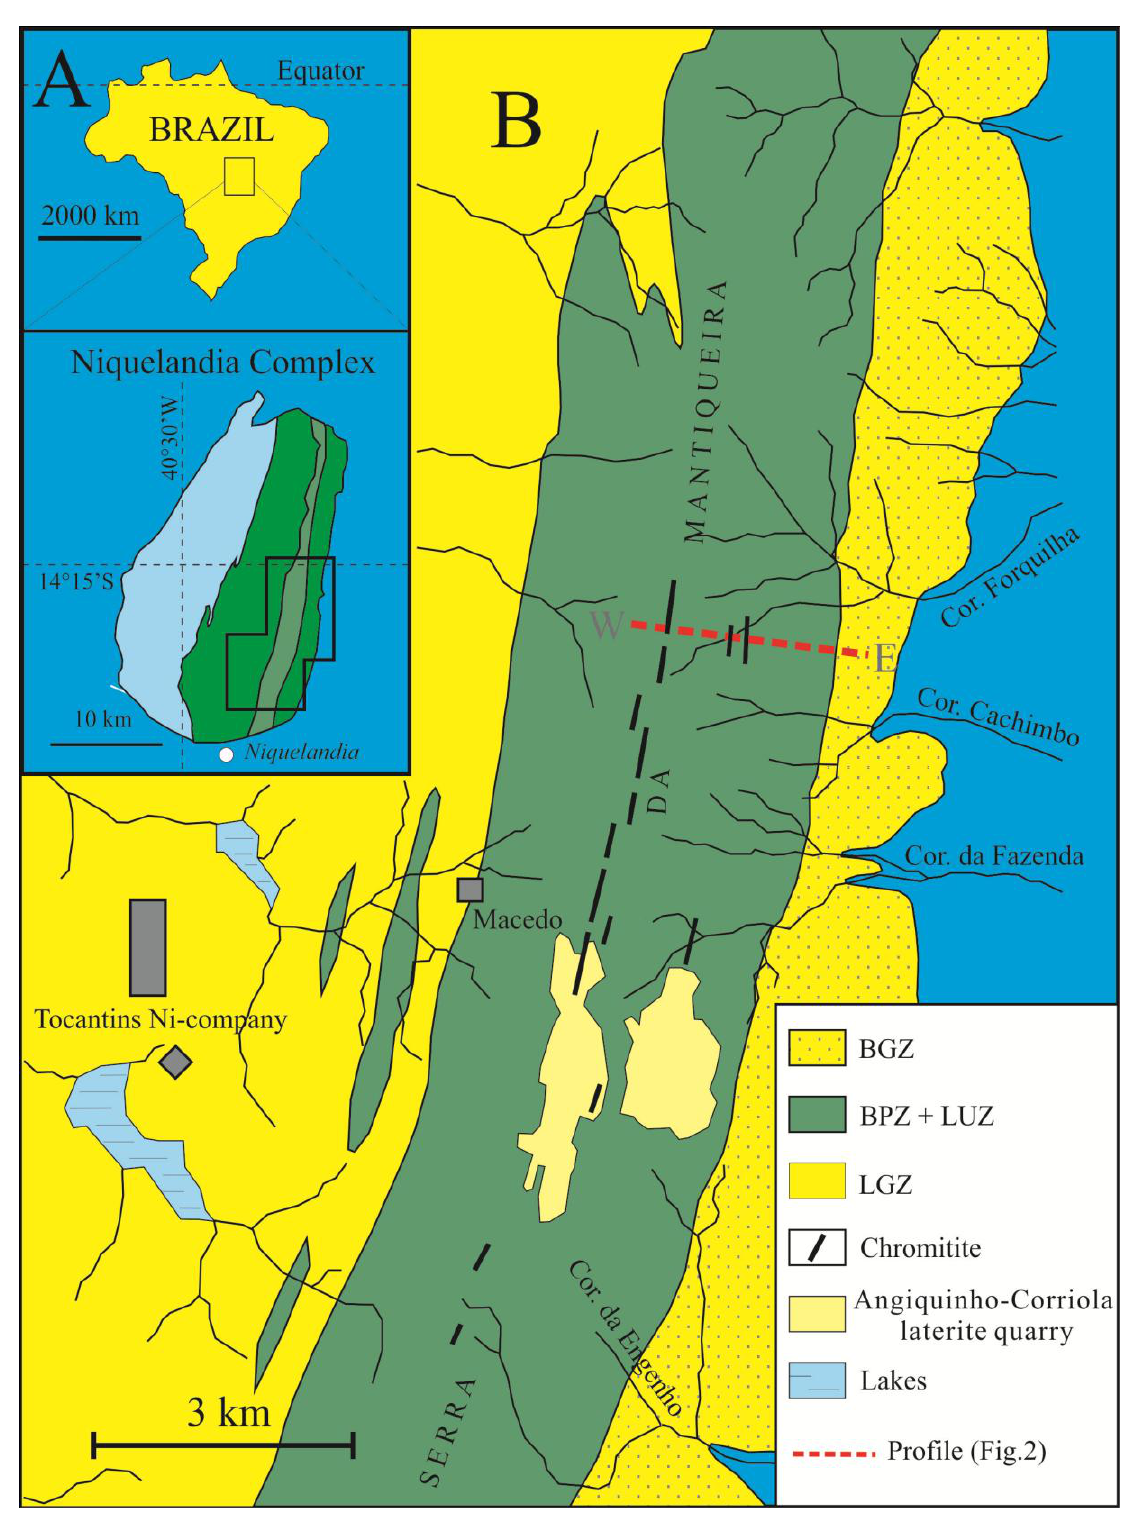
Figure 1. ( A ) Geographic location of the Niquelândia igneous complex; ( B ) Geological setting of the chromitite layers; BGZ = basal gabbro zone, BPZ + LUZ = basal peridotite zone and layered ultramafic zone, LGZ = lower gabbro zone, W − E = geologic profile in Figure 2 (Modified after